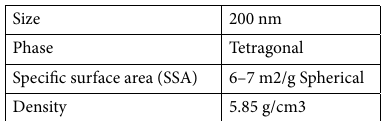
Table 1. General properties of BaTiO 3 nanoparticles 73 .